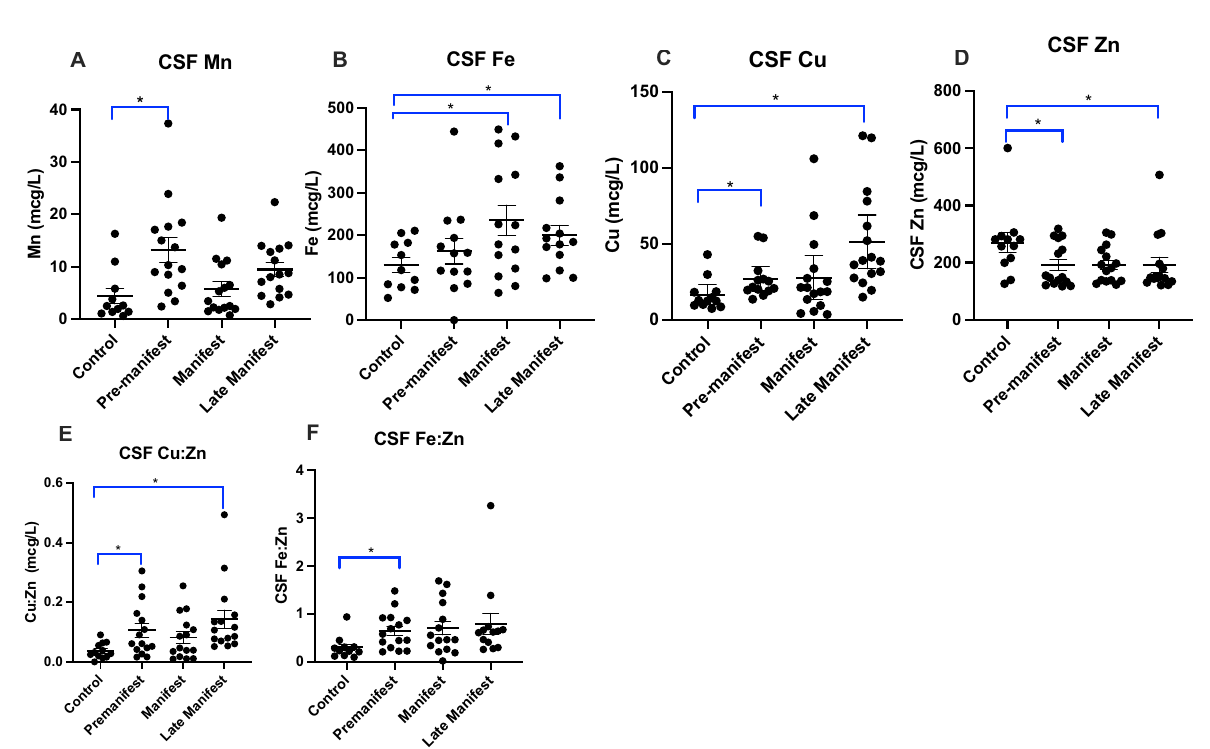
Figure 1. Cerebrospinal fluid (CSF) ( A ) manganese (Mn), ( B ) iron (Fe), ( C ) copper (Cu), ( D ) zinc (Zn) metal levels with the ratio of ( D ) Cu:Zn and ( E ) Fe:Zn between control and HD participants analyzed using 1-way ANOVA with post-hoc testing after determination of significant (p < 0.05) main effects. Data are shown as individual data points with the mean ± sem. An asterisk indicates a p-value <